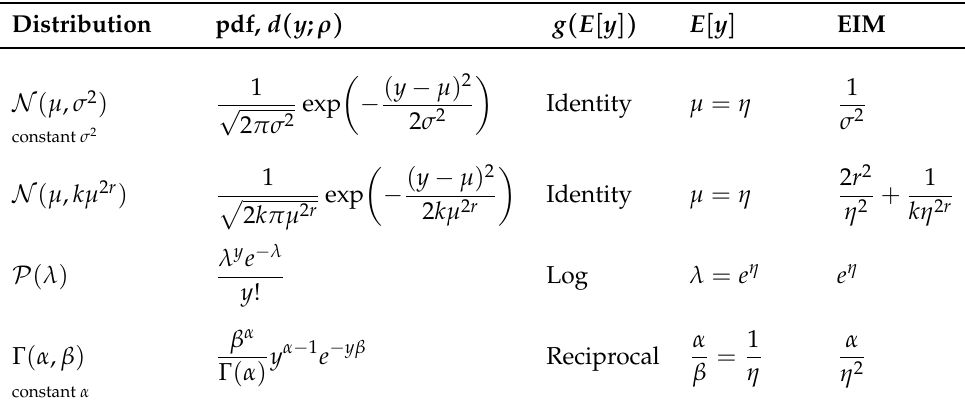
Table 1. Density function, link function, expectation of the response variable as a function of η = η ( x ; θ ) and the EIM for the probability distributions used in this